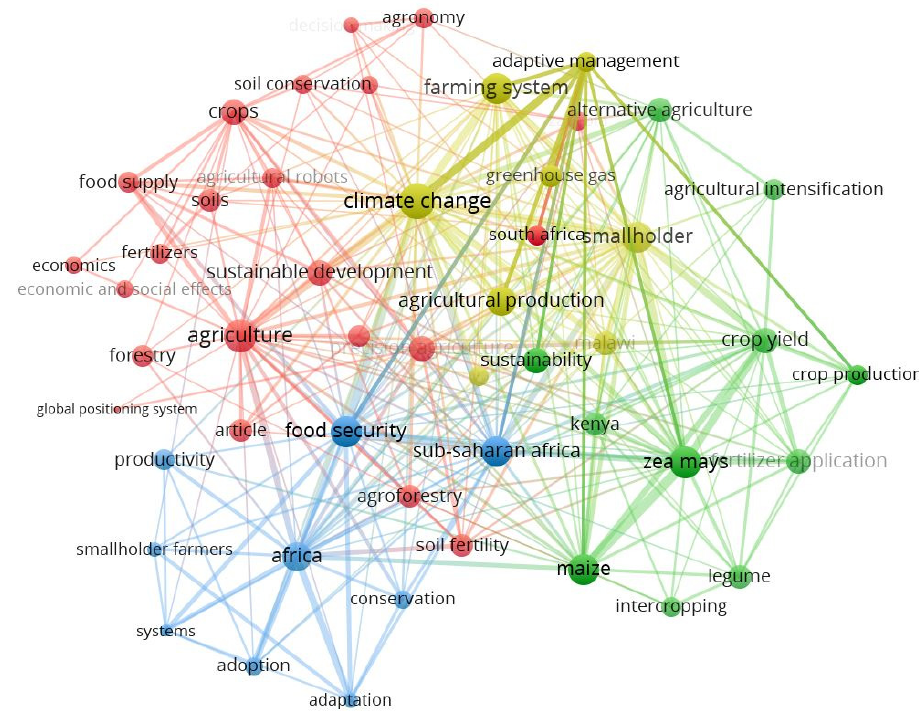
Figure 5. Keyword Figure 5. Keyword occurrences.